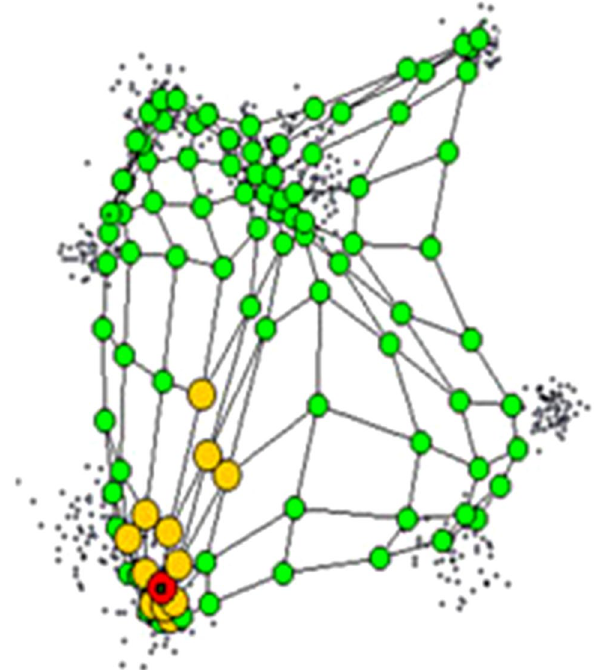
Fig. 16 The general configuration of a